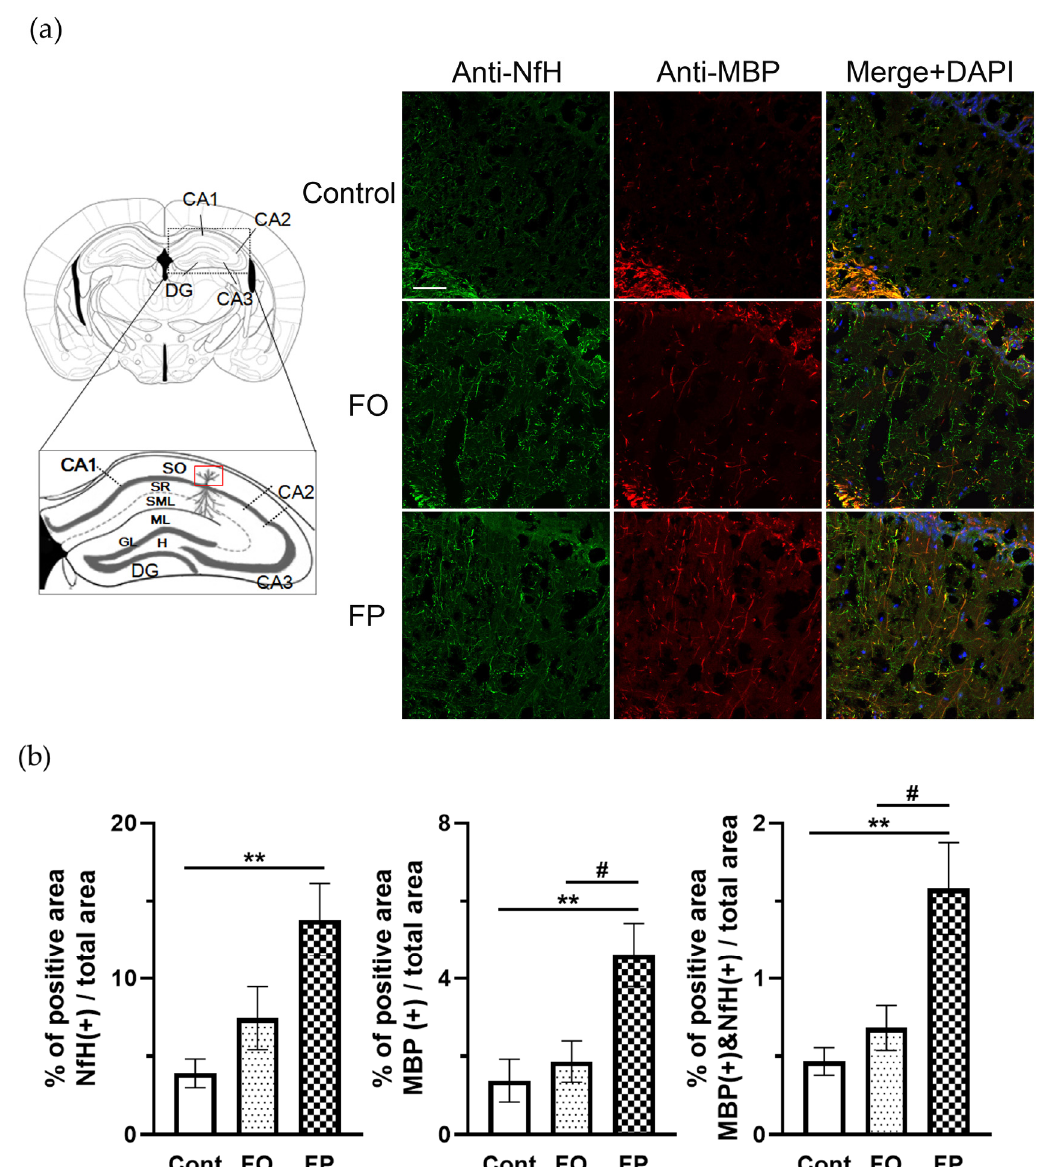
Figure 3. Fish protein (FP) feeding protected the myelin sheath in 6-month-old senescence-accelerated mouse CA1 region of hippocampus (Hipp). ( a ) Schematic illustration showing the Hipp section that was included in region for visualizing (red box). Images of double staining with neurofilament heavy chain (NfH; green) and myelin basic protein (MBP; red) in the CA1 region of Hipp. The scale bar denotes 50 µm. DAPI = 4 ′ ,6-diamidino-2-phenylindole. ( b ) NfH or MBP positive area, and MBP/NfH double-positive area per total analyzed area were quantified in the CA1 Hipp region. Data are presented as the mean ± standard error of the mean (the average of two sections from at least 6 mice per group). ** p < 0.01 vs. control diet group, # p < 0.05 vs. FO group. DG = dentate gyrus; SO = stratum oriens; SR = stratum radiatum; SLM = stratum lacunosum; ML = molecular layer of dentate gyrus; GL = granule cell layer; H = hilus of dentate gyrus; Cont = control.